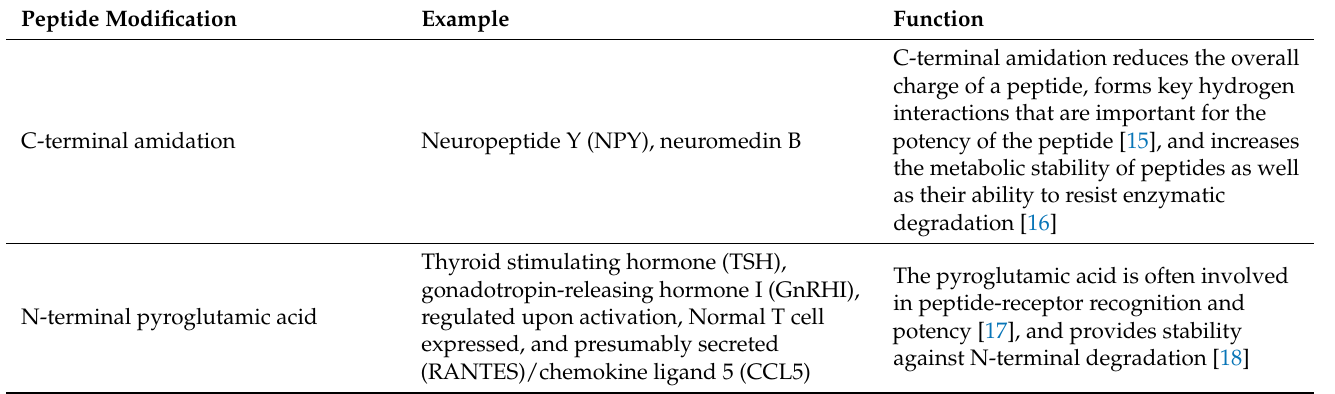
Table 1. Examples of peptide hormone